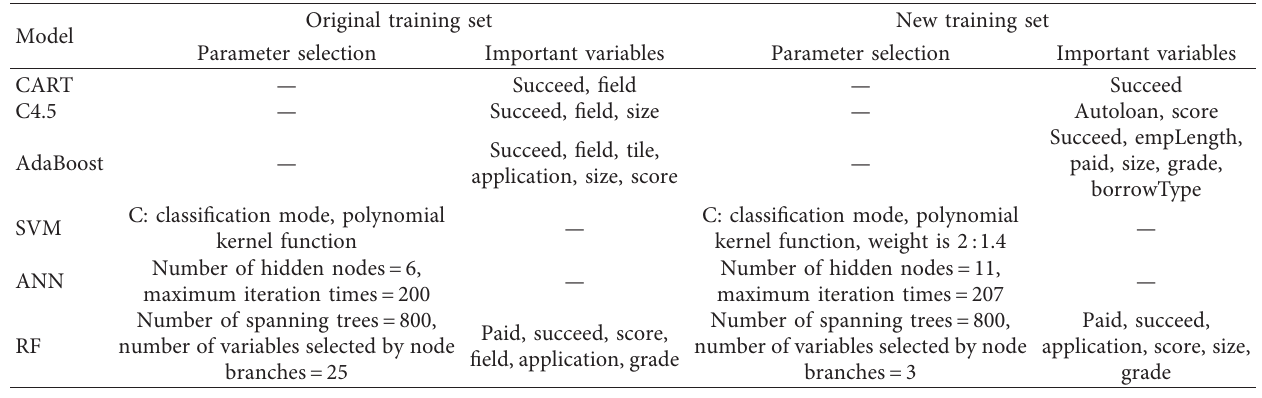
Table 3: Parameter selection and important variables of each model.